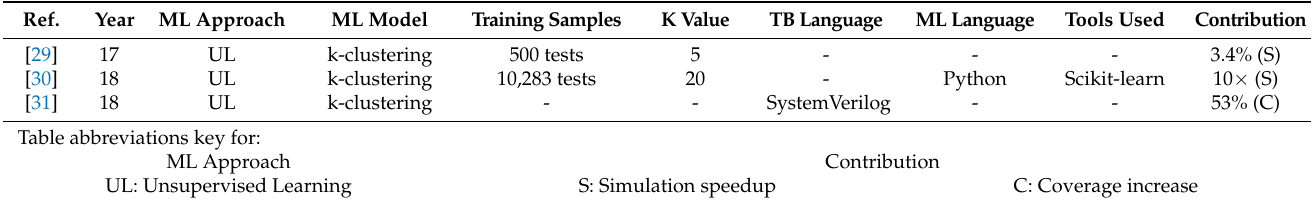
Table 2. Comparative summary of state of the art ML contributions in Section 5.2. Ref.